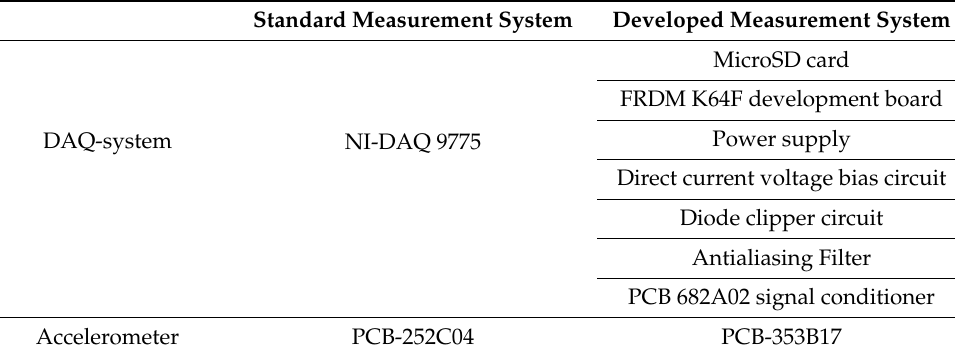
Figure 4. Measurement set-up with the standard and the developed vibration measurement system. Table 3. Components for the standard and the developed measurement system.